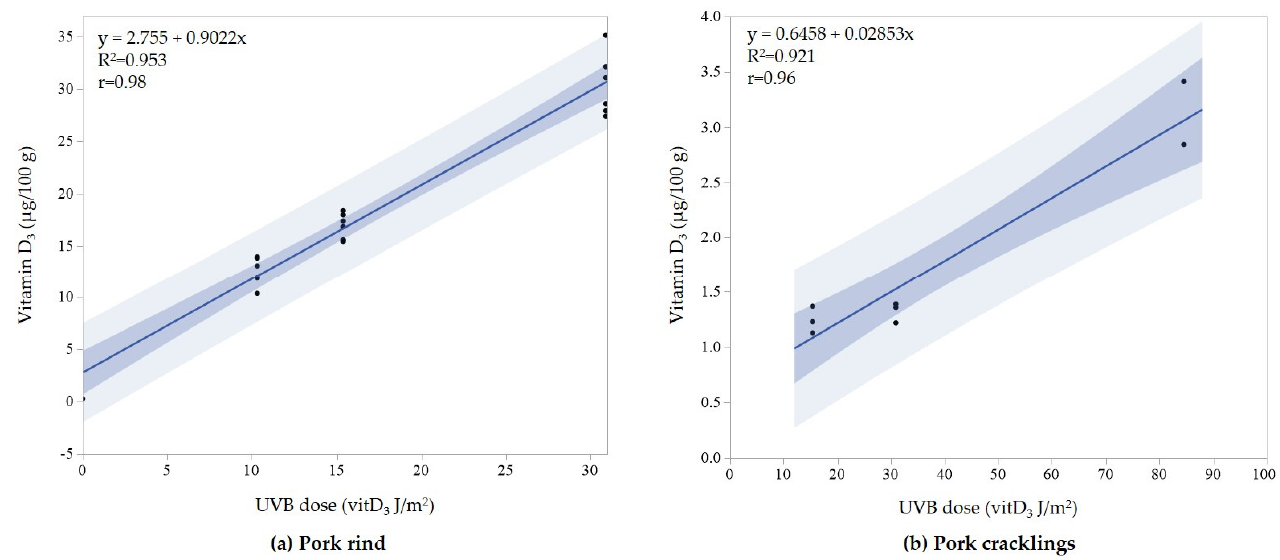
Figure 1. The production of vitamin D 3 related to the exposed UVB dose. ( a ) Vitamin D 3 ( µ g/100 g) produced in raw pork rind at UVB doses of 10, 15, and 31 vitD 3 J/m 2 ; ( b ) Vitamin D 3 ( µ g/100 g) produced in pork cracklings produced from pork rind UVB exposed by 15, 31, and 84 vitD 3 J/m 2 . Dark shade represents the confidence interval for the fitted line, while light shade represents a confidence interval for individual values ( p ≤ 0.05).